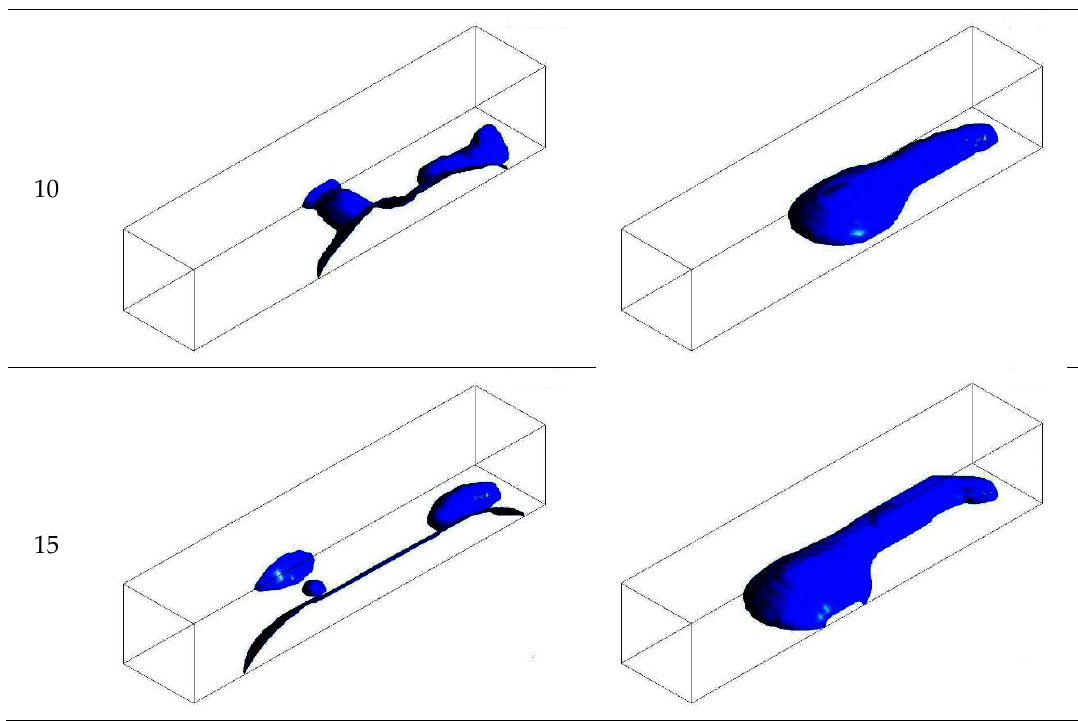
Figure 19. Time evolution of the water droplet emerging from the hole in hydrophilic GDL surface (The GDL surface contact angle is 45°).